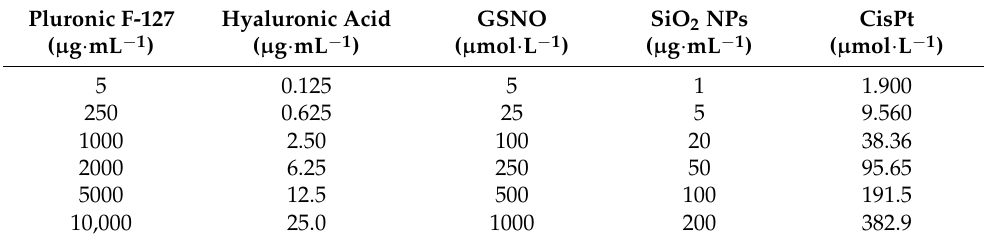
Table 2. Corresponding concentrations for Pluronic F-127 hydrogel, hyaluronic acid (HA), GSNO, SiO 2 NPs, and CisPt used on the MDA-MB-231 cell line for MTT assay. Pluronic F-127 Hyaluronic ( µ g · mL − 1 )